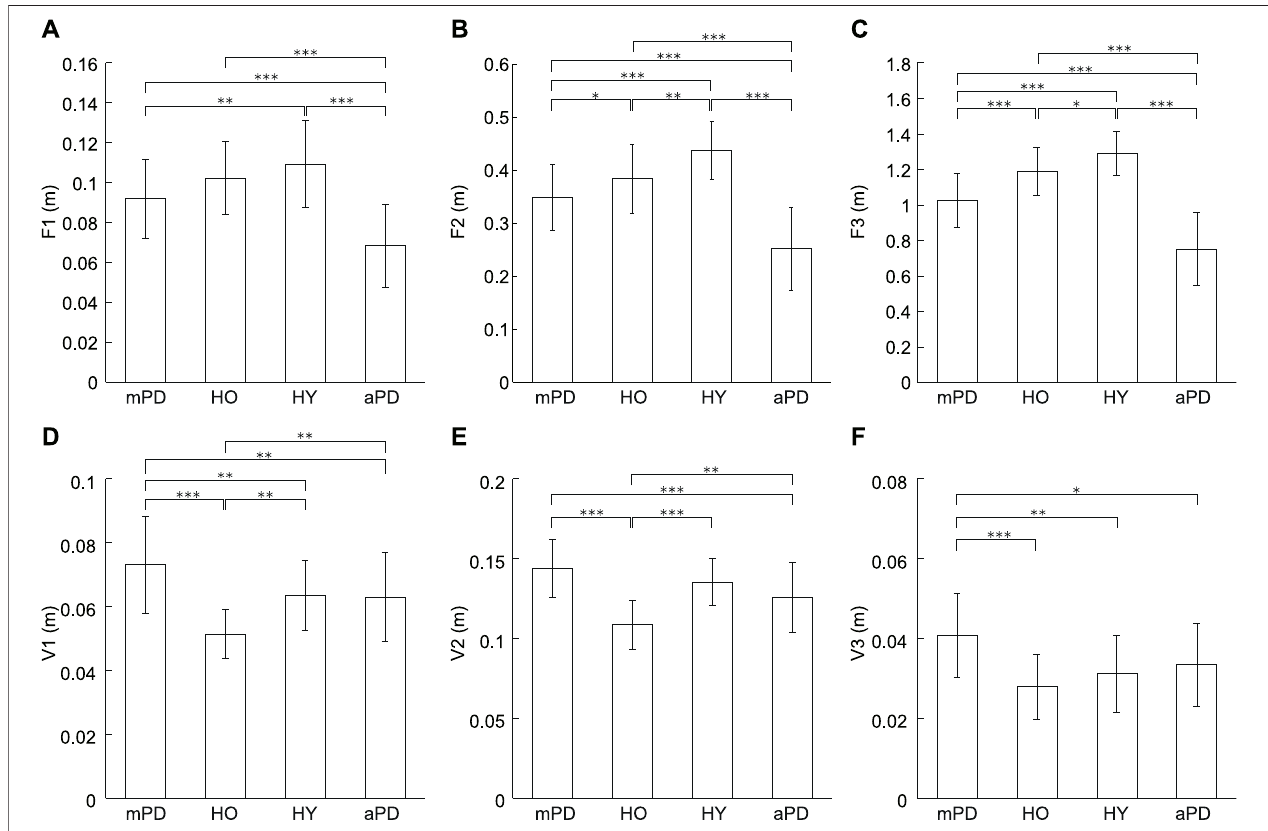
FIGURE 3 | Averages of the forward and vertical displacements. (A) F1, (B) F2, (C) F3, (D) V1, (E) V2, and (F) V3. mPD, HO, HY, and aPD represent mild PD patients, healthy older individuals, healthy young individuals, and advanced PD patients, respectively. The error bars indicate the standard deviations between the participants. *, **, and *** represent p < 0.05, p < 0.01, and p < 0.001,